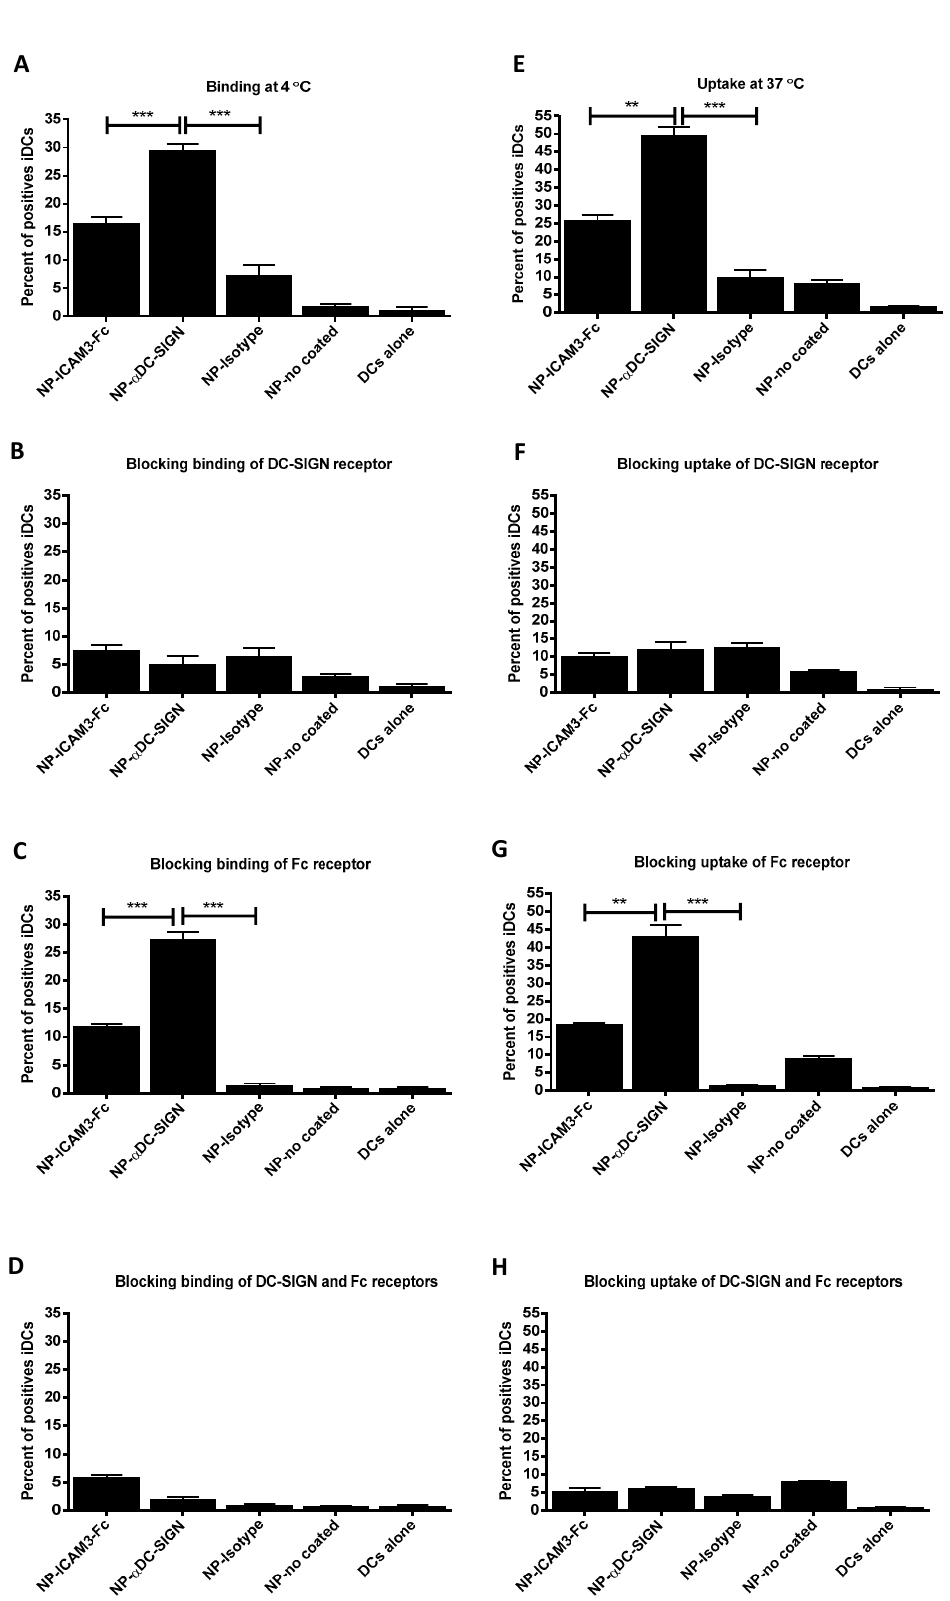
Figure 2. DC-SIGN specific antibodies are superior in targeting NP vaccine to DCs with respect to ICAM3-Fc. Binding ( A – D ) and uptake ( E – H ) of NP vaccine coated with various DC-SIGN ligands by DCs was evaluated. NP vaccine harbouring FITC-labelled TT peptide Ag and surface coated with ICAM3-Fc protein, DC-SIGN-specific Ab, isotype control Abs or without surface coat (no coated) were incubated with DCs for 1 h at 4 °C ( A – D ) or 37 °C ( E – H ). DCs cultured in medium without NP vaccines were included as a negative control. The percentage of DCs that had internalized the